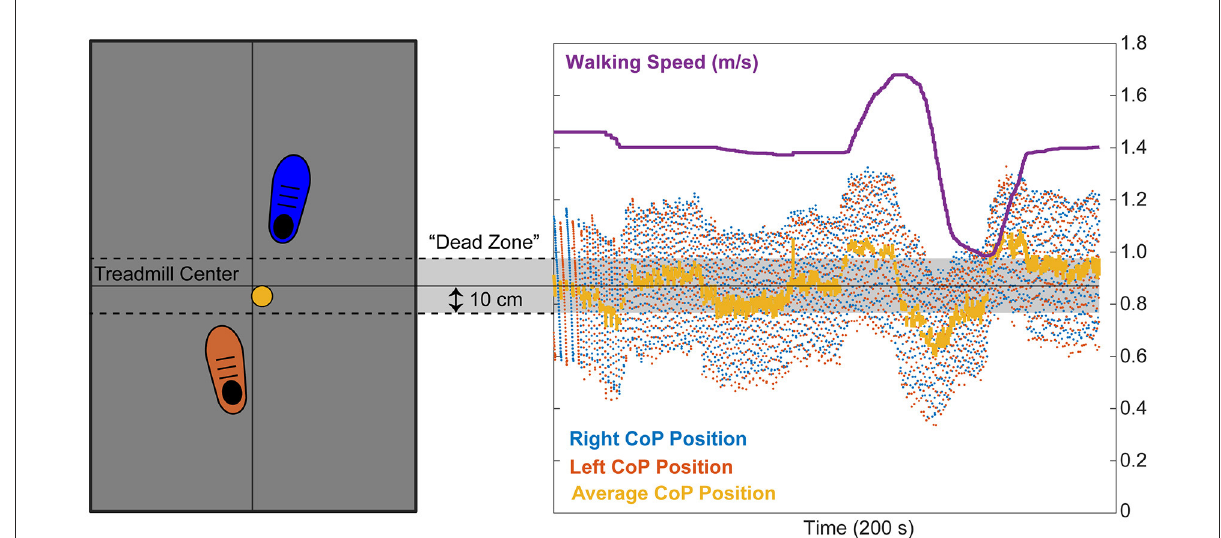
FIGURE1 In self-pace mode, participants started walking on a split-belt treadmill at their preferred overground walking speed. We recorded participants’ instantaneous bilateral centers of pressure (CoP) from each belt in real time and averaged the sides to estimate their relative fore/aft position on the treadmill (yellow dot and line). When the participant stayed centered on the treadmill (i.e., average CoP location during double support within the 20cm “dead zone”), treadmill speed remained constant. When the participant’s average CoP location during double support moved anterior or posterior to the dead zone, the treadmill speed increased or decreased linearly with the distance from center,